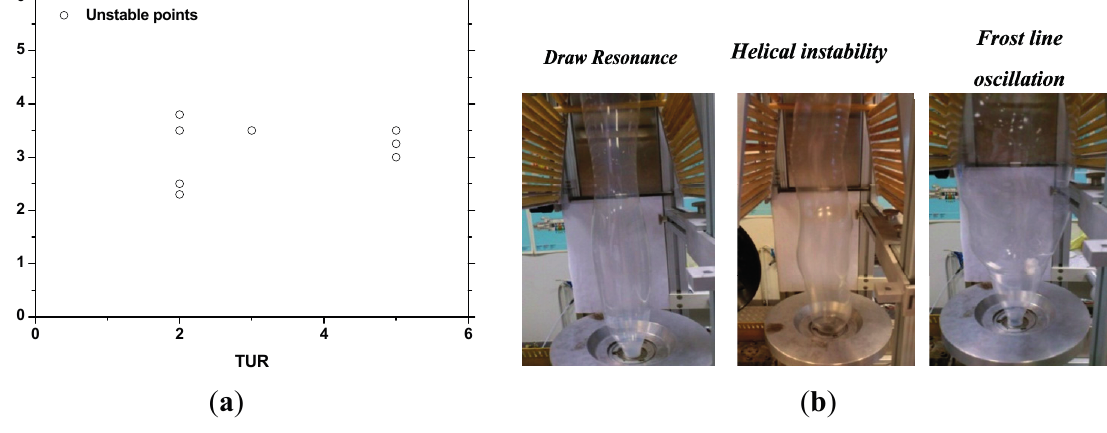
Figure 13. Stability map (BUR versus TUR) of neat PLA at 180°C ( a ). Various instabilities observed ( b